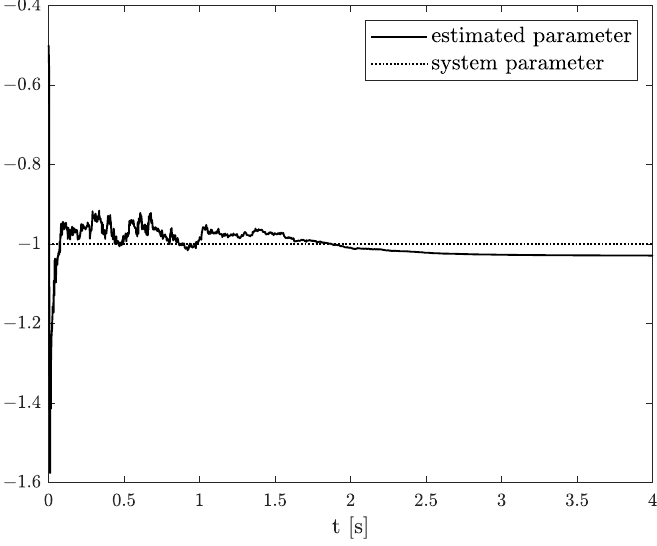
Figure 10. Original and estimated parameter from Example